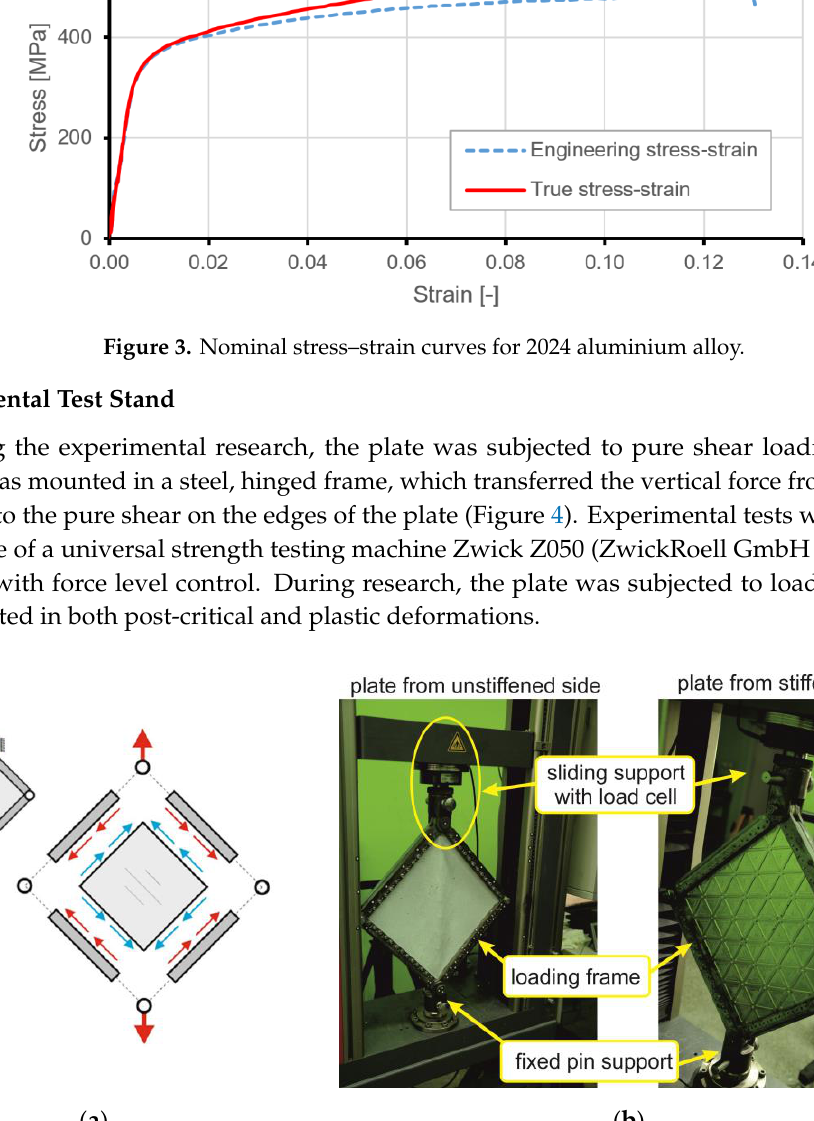
Figure 3. Nominal stress–strain curves for 2024 aluminium alloy.